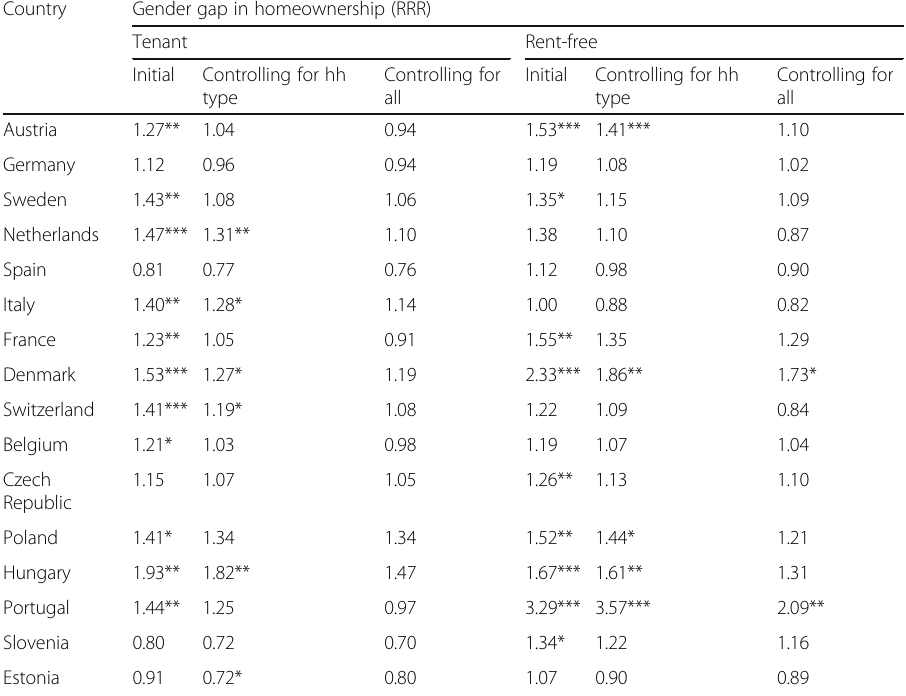
Table 3 Gender gap in the exclusion from home ownership (homeowners versus tenant or rent- free) by country of residence. Results of a multinomial regression model expressed in relative risk ratios (RRR) Country Gender gap in homeownership (RRR) Tenant Rent-free Initial Controlling for hh Controlling for Initial Controlling for hh Controlling for type all type all